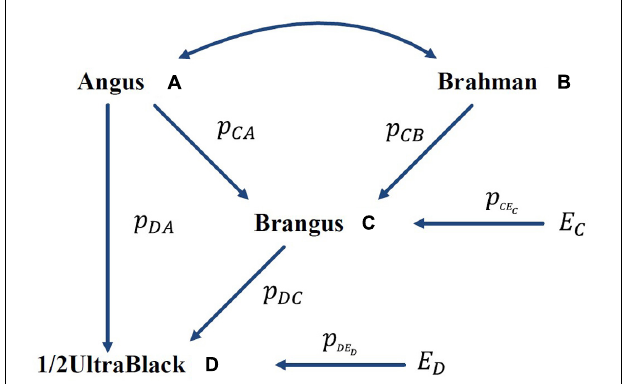
FIGURE 1 | Path diagram of the relationships between Brangus (and 1/2 UltraBlack) and two ancestral breeds, namely Angus and Brahman p yx = path coefficient from x to y ; r AB = correlation between Angus (A) and Brahman